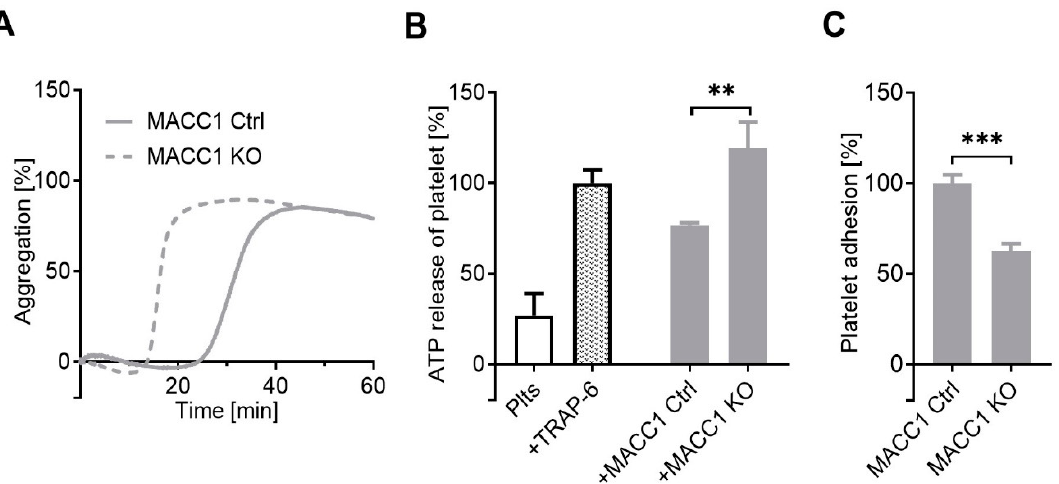
Figure 1. Dependency of platelet activation by SW620 cells from the MACC1 expression. ( A ) Representative curves of platelet aggregation by light transmission measurement after contact with MACC1-positive SW620 Ctrl cells or the MACC1 KO variant. ( B ) ATP release from platelet dense granule induced by SW620 Ctrl and MACC1 KO cells. ( C ) Platelet adhesion to a cell layer of SW620 Ctrl or MACC1 KO cells exclude a diminished cell contact formation as the reason for lower platelet activation by the MACC1-positive cells. ** p < 0.01, *** p < 0.001 .